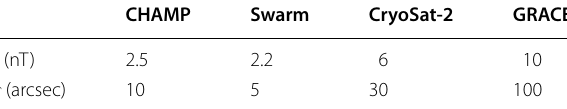
1 Entries related to g 0 1 B-spline coefficients and platform magnetometer data are zero Table 3 Chosen values of σ and ψ for the different satellites. The values under Swarm apply to the data from the two Swarm satellites in this study (Swarm-A and Swarm-B), the values under CryoSat-2 to the data of the three magnetometers (FGM1, FGM2 and FGM3), and the values under GRACE to the data from both GRACE satellites (GRACE-A and GRACE-B)